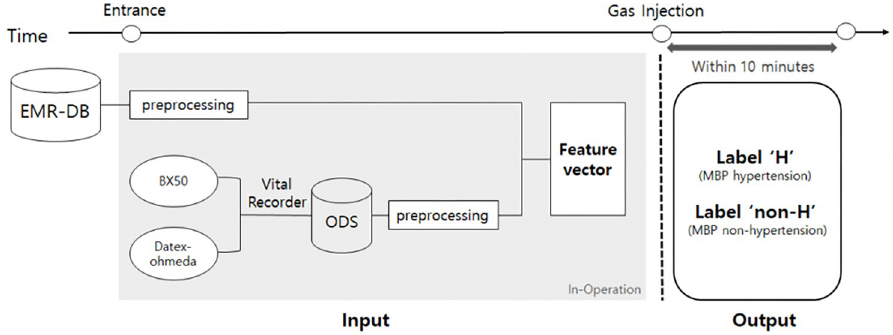
Fig 2. Overall process of the mean blood pressure hypertension prediction. EMR-DB, electronic medical record database; ODS, operation data server.